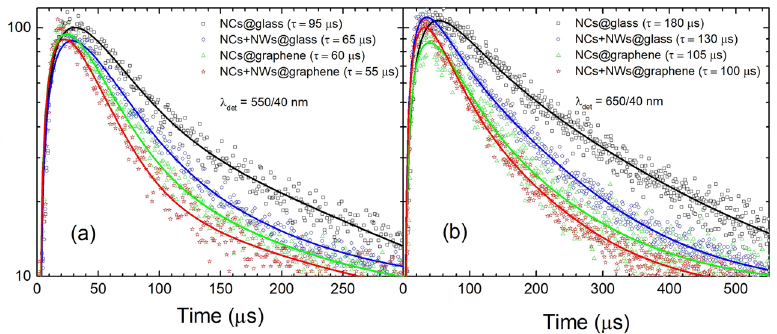
Figure 5. Luminescence transients of ( a ) green and ( b ) red emission of the NCs. Black and green lines/points correspond to NCs on glass and graphene, respectively, while blue and red lines/points correspond to NCs combined with NWs placed on glass and graphene, respectively.